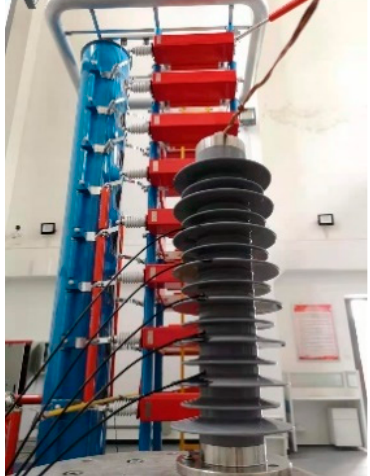
Figure 4. The impulse voltage generator.